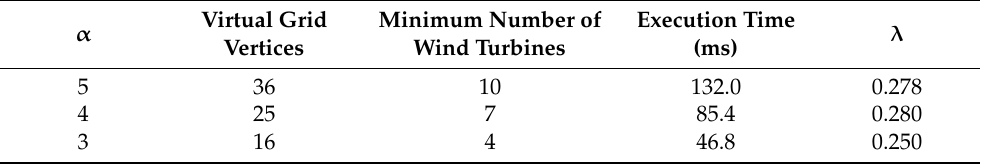
Table 1. Simulation results for different values of α